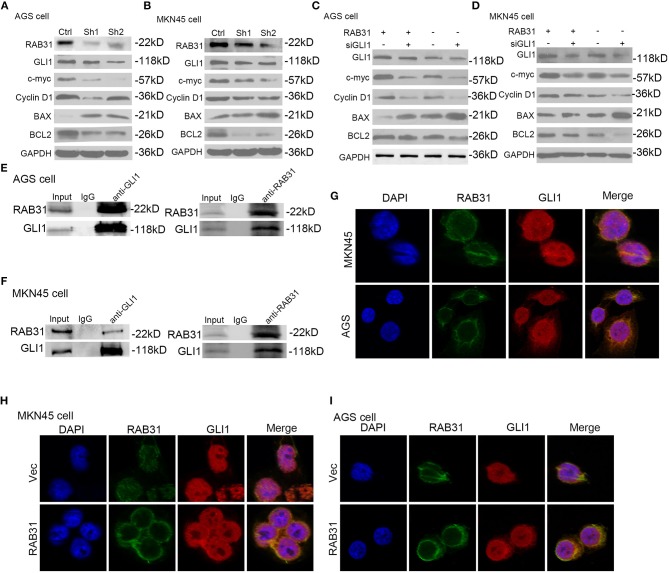
RAB31 mediated its downstream proteins via GLI1. (A,B) Expression of GLI1, cyclin D1, c-myc, BAX, and Bcl-2 were detected by Western blotting in AGS and MKN45 cells with RAB31 expression silenced. (C,D) Western blotting was conducted to detect the expression of GLI1, cyclin D1, c-myc, BAX, and Bcl-2 in AGS and MKN45 cells with simultaneous RAB31 plasmid and GLI1 siRNA co-transfection. (E,F) Co-IP assay was utilized to investigate the interaction between RAB31 and GLI1 expression. The assay was conducted using a GLI1 antibody to pulldown the RAB31 protein or a RAB31 antibody to pulldown the GLI1 protein. (G) Co-localization of the GLI1 and RAB31 proteins was evaluated by immunofluorescence. (H,I) Immunofluorescence was conducted to measure the fluorescence intensity of RAB31 and GLI1 in AGS and MKN45 cells transfected with the RAB31 plasmid and vector controls.